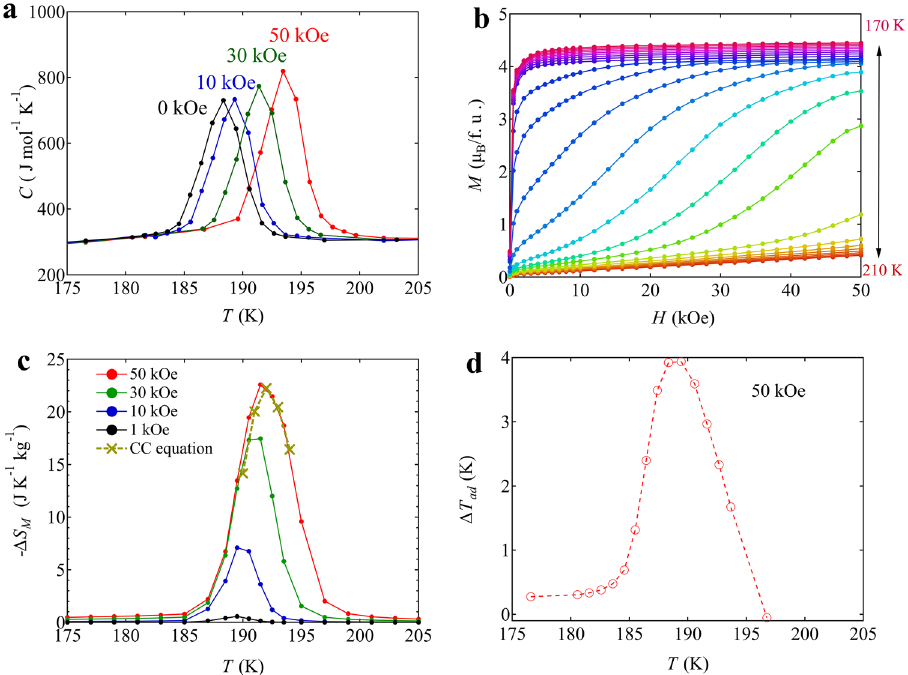
Figure 3. ( a ) Specific heat-capacity curves of BiCu 3 Cr 4 O 12 measured under applied fields from 0 to 50 kOe. ( b ) Isothermal magnetization as a function of applied field for BiCu 3 Cr 4 O 12 between 170 and 210 K. ( c ) Isothermal entropy changes for BiCu 3 Cr 4 O 12 obtained from the magnetization changes measured under magnetic fields from 0 to 50 kOe. Yellow cross marks with a line represents the entropy changes estimated by the Clausius– Clapeyron equation using the magnetization data. ( d ) Calculated adiabatic temperature change induced by applying a magnetic field of 50